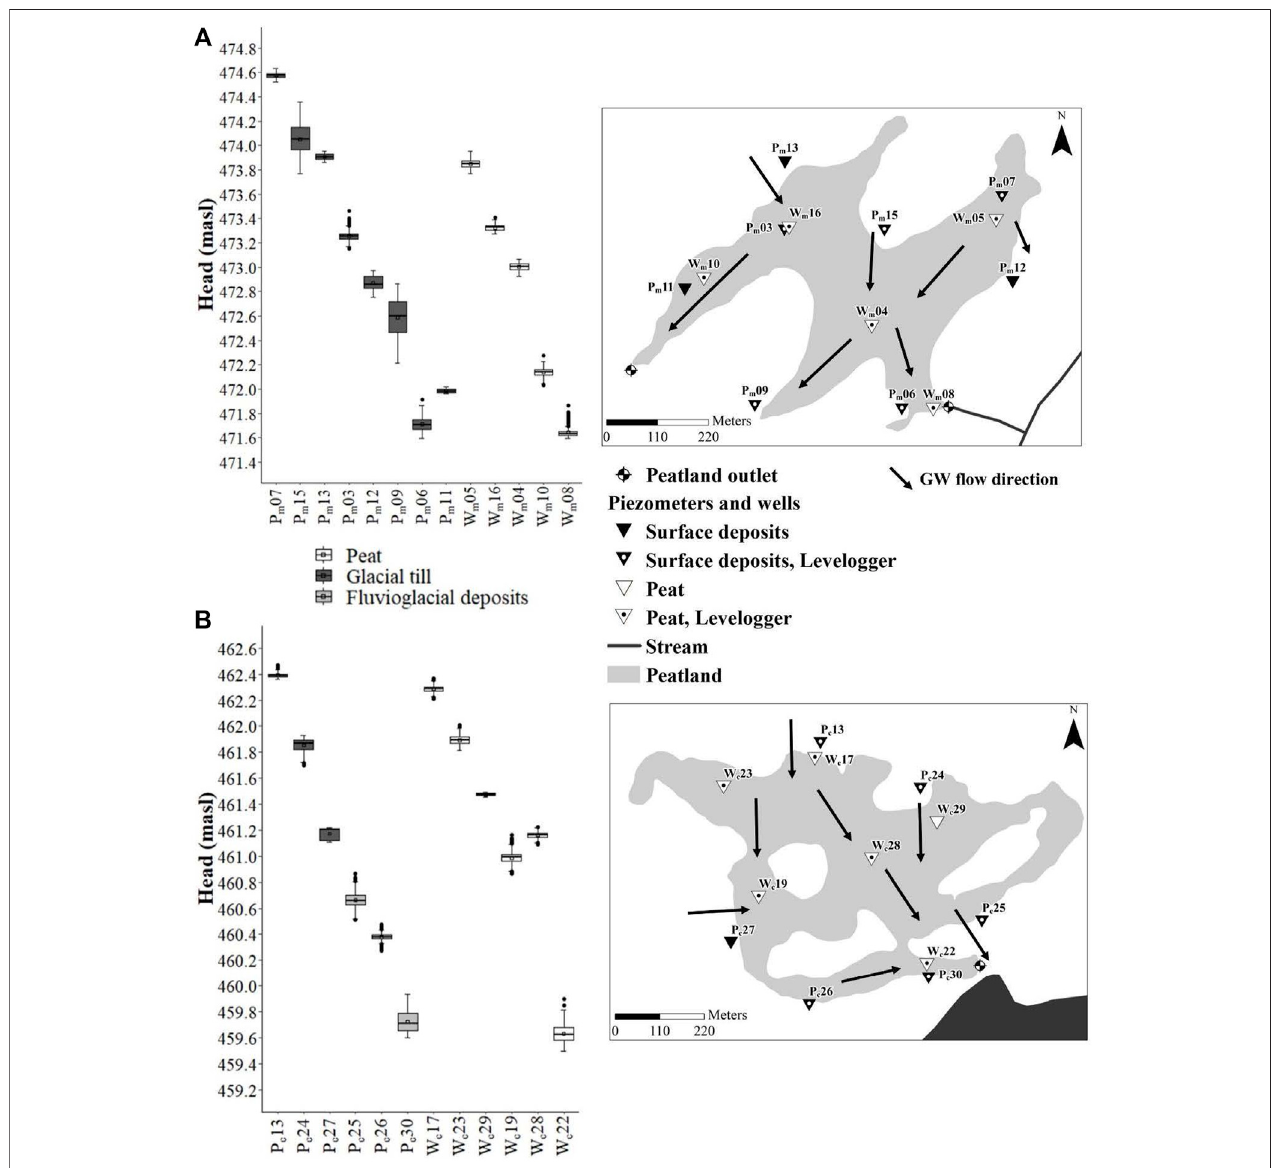
FIGURE5| AveragedailyheadsfromJunetoOctober(2018and2019)formonitoredwells(peat)andpiezometers(mineraldeposits)andforunmonitoredstations used in the Darcy fl ow calculation (P m 13, P m 12, P c 27, W c 29) for (A) the Misask peatland and (B) the Cheinu peatland. The squares indicate mean values. Panels on the right indicate groundwater fl ow directions.